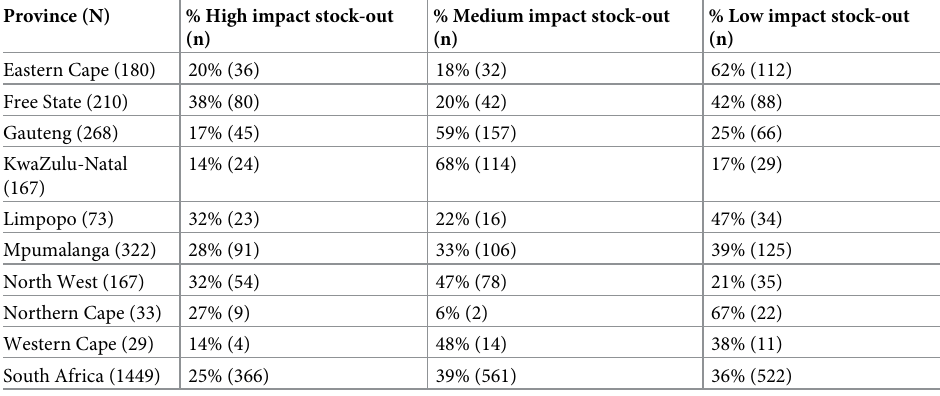
Table 5. Proportions of stock-outs leading to high, medium, and low impact out of 1449 individual stock-outs reported by province and nationwide in the three-month period prior to contact.